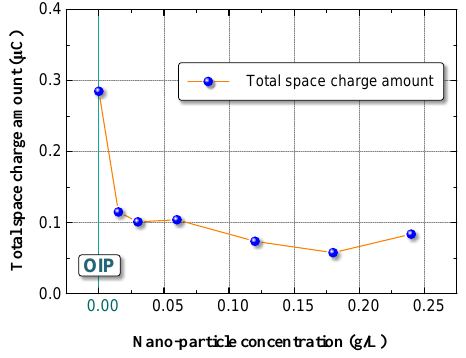
Figure 10. Total charge amount in the OIP sample and NOIP sample.